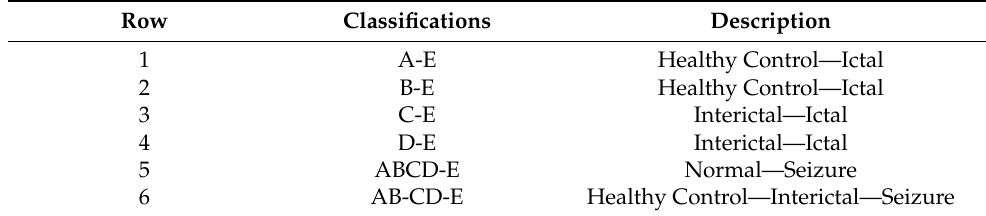
Table 3. Further details about six problem